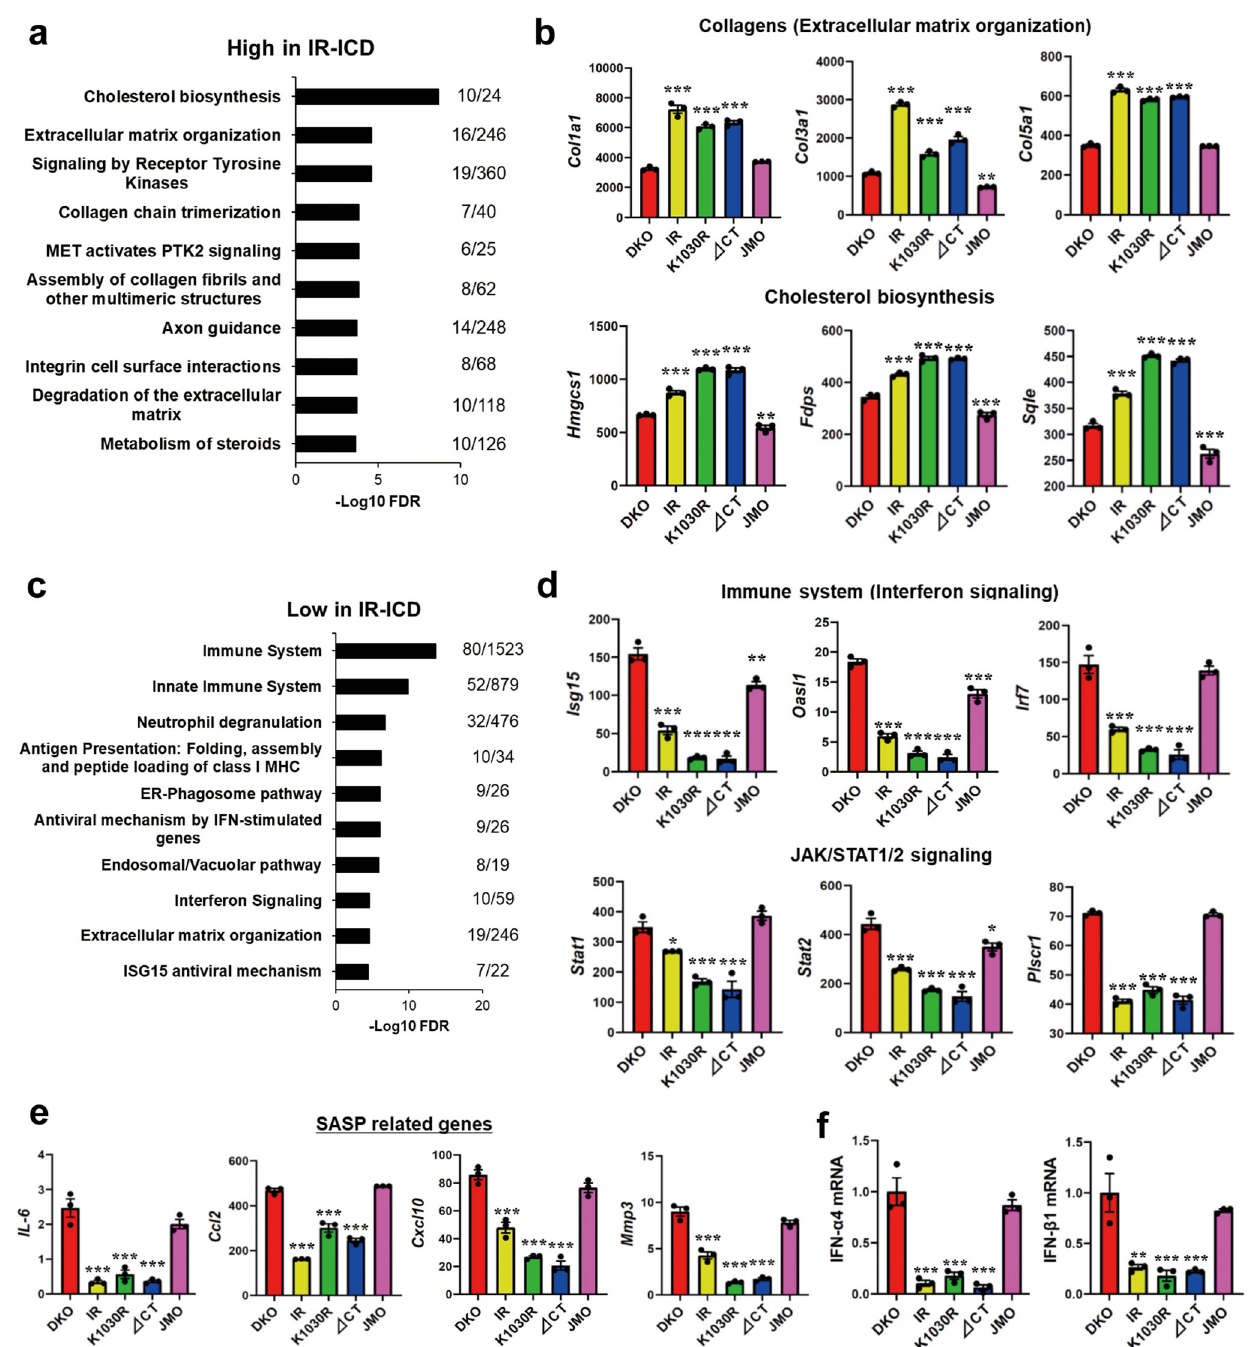
Fig. 5 | Analysis of IR kinase-independently regulated genes. a Pathway analysis showing the top 10 upregulated REACTOME pathways by IR-ICD. The functional enrichment analysis was tested by the STRING database, where FDRs were calcu- lated using the Benjamini – Hochberg procedure. Plots are − log10 transforms of enrichmentFDRvalue. b Quanti fi cationofexemplarygenesinimportantpathways from the high expression in IR-ICD cluster at the basal. Data are means±SEM of genes intensity values ( n =3). ** P <0.01, *** P <0.001 vs. DKO, one-way ANOVA. c PathwayanalysisshowingthetoptendownregulatedREACTOMEpathwaysbyIR- ICD.ThefunctionalenrichmentanalysiswastestedbytheSTRINGdatabase,where